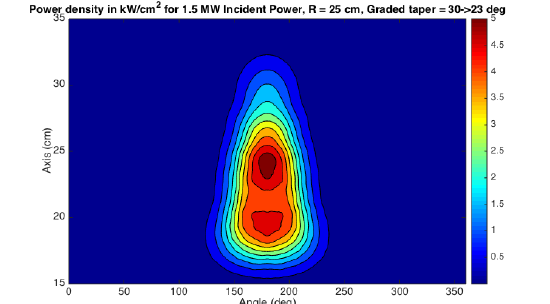
Fig. 13 . RF power density on cylindrical wall for 1.5 MW input